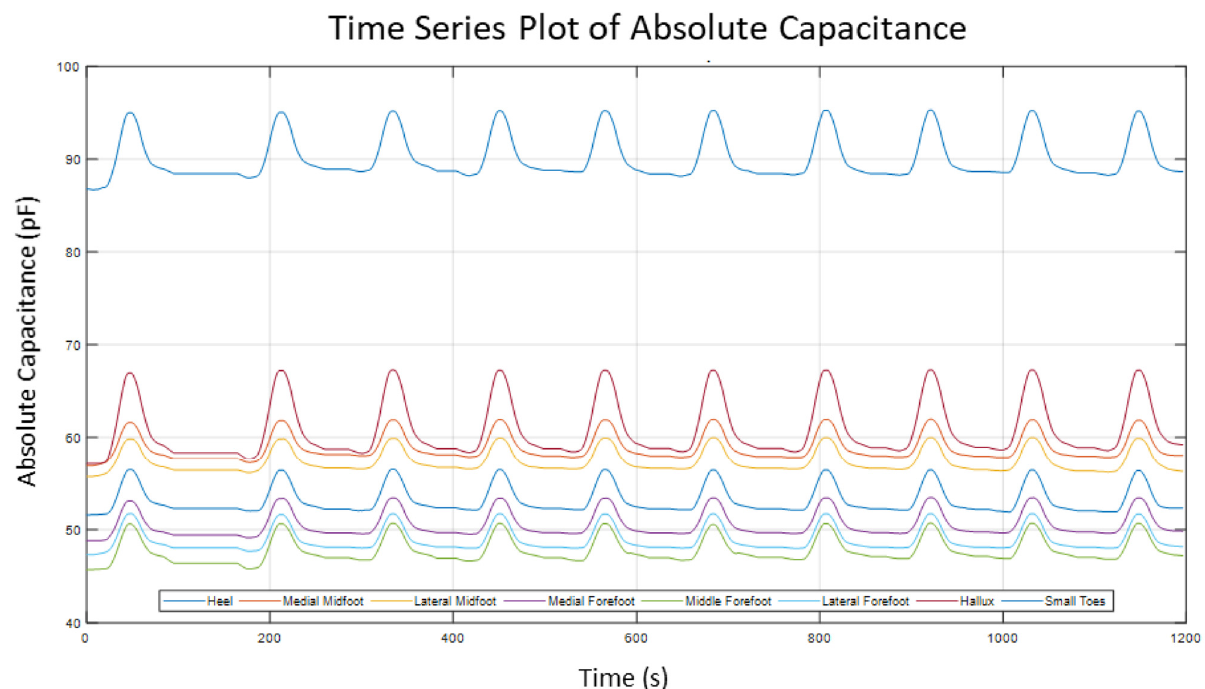
Figure 14. Time series graph of Absolute Capacitance of 8 sensor pads.